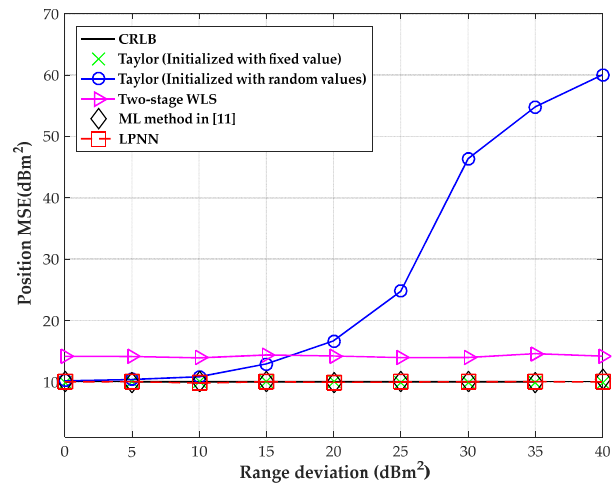
Figure 10. MSE versus level of time asynchronization with the source position located at ( 300, − 280 ) m. In the second test, the effect of sensor location error is investigated and the range deviation variance is fixed at 400 m 2 here. Four sensors are employed as in the first test. Figure 11 shows the MSEs versus the level of measurement noise under mild sensor location errors, namely σ 2 s = 1 m 2 . It is observed from the figure that the proposed analog neural method outperforms the randomly initialized Taylor algorithm and two-stage WLS algorithm in a large measurement noise range. The MSEs versus the sensor location error variance σ 2 s ∈ [ 1, 100 ] m 2 with σ 2 = 10 m 2 are exhibited